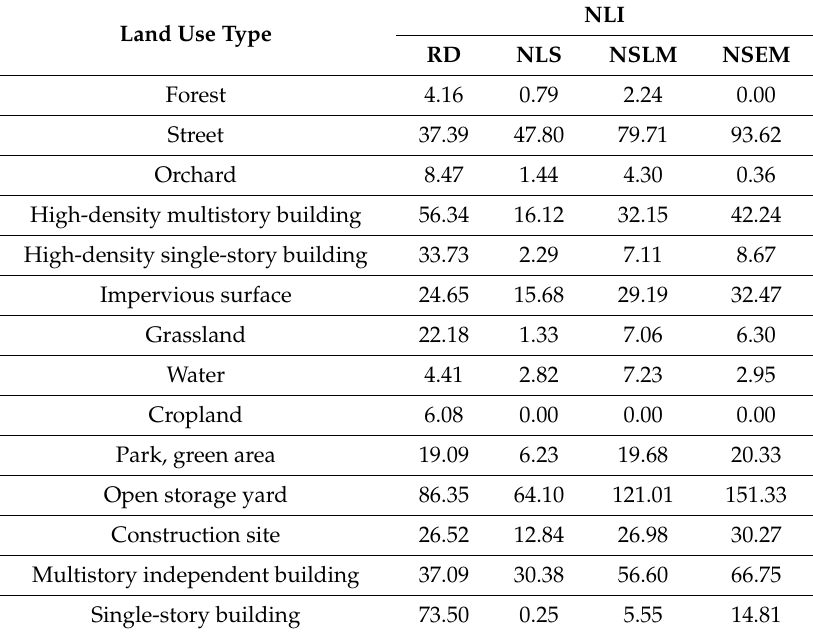
Table A4. NLIs of reference data and analysis data from di ff erent models in